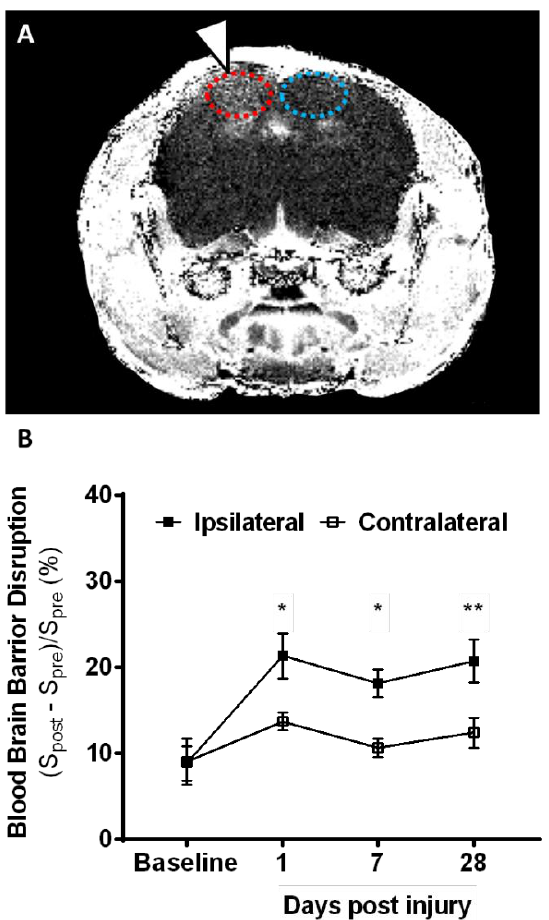
Figure 2. Post-contrast T 1 -weighted MRI detects persistent blood–brain barrier (BBB) damage after contusion injury in aged animals. ( A ) Enhancement ratio map acquired at 28 days post injury (white arrow), as calculated from T 1 -weighted magnetic resonance (MR) images acquired pre- and post-injection of 1 mmol/kg Magnevist ® on a 14.1-tesla MRI system using the corresponding parameters: TE/TR = 4.6/112 ms; slice thickness = 0.5 mm; number of averages = 30; flip angle = 10; matrix = 256 × 192; field of view (FOV) = 25 × 25 mm 2 ; acquisition time = 10 min 41 s. Regions of interest (ROIs) used for quantification of ipsilateral (red) and contralateral (blue) signals are superimposed. ( B ) Quantification of the mean intensity ratio, where S pre and S post represent the signal intensity before and after contrast injection, in ipsilateral (closed black squares) and contralateral (open black squares) ROIs shows a significant increase in enhancement in the ipsilateral ROI at every time point post injury. Error bars represent means and SEM. Two-way repeated measure ANOVA found significant differences in the time effect (F = 4.575, p < 0.05) and brain region effect (F = 32.24, p < 0.0001), as well as their interaction (F = 3.77, p < 0.05), with Sidak correction. * p < 0.05; ** p < 0.01 .